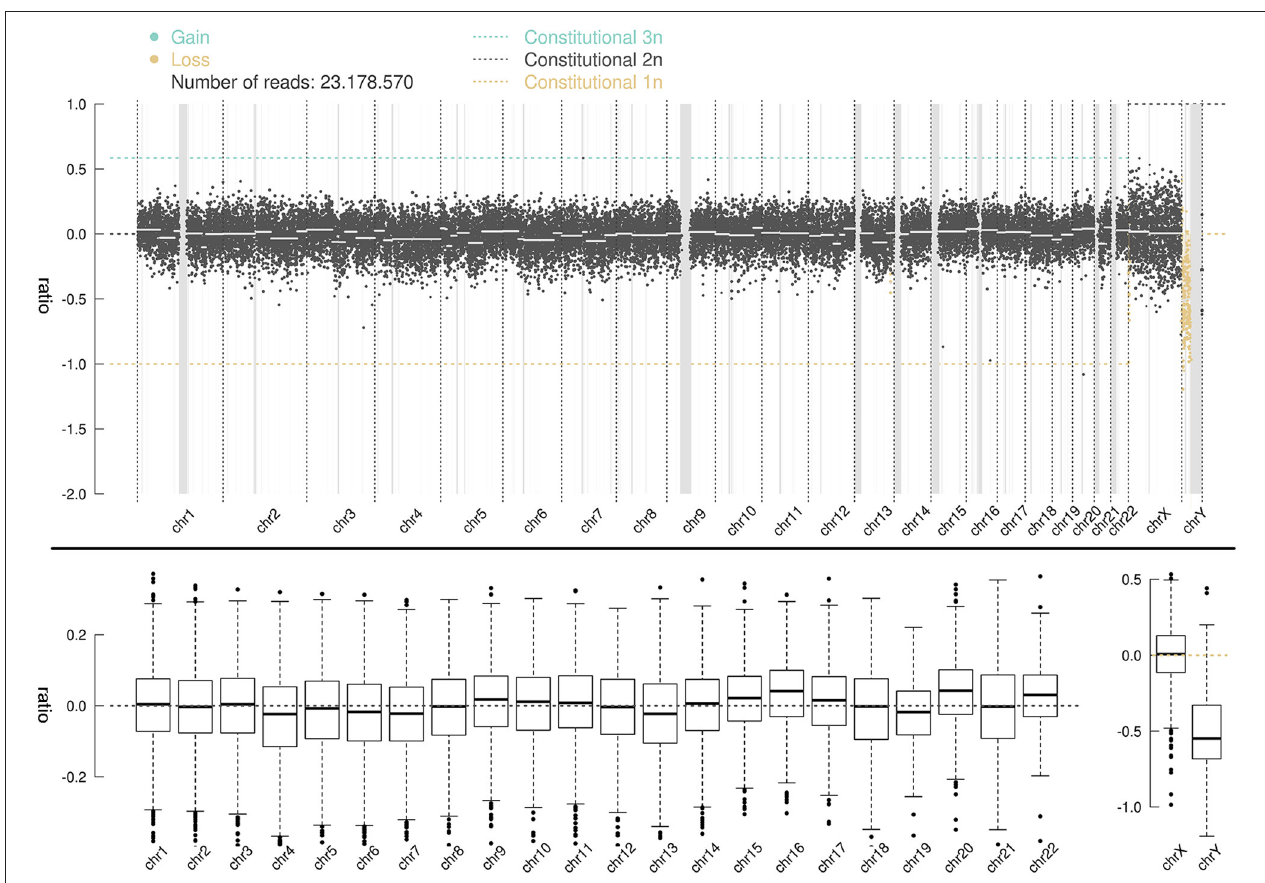
FIGURE 3 | CNV-seq distribution map for 46 chromosomes; the ordinate ratio represents log 2 test abscissa represents the chromosome band. A ratio of − 1 indicates that one copy is lost; a ratio of 0 represents a normal value; a ratio of 0.58 indicates that one copy is gained; a ratio between − 1 and 0 represents a mosaic deletion, and the ratio of abnormal cells is ∼ 2 (1-2 ratio